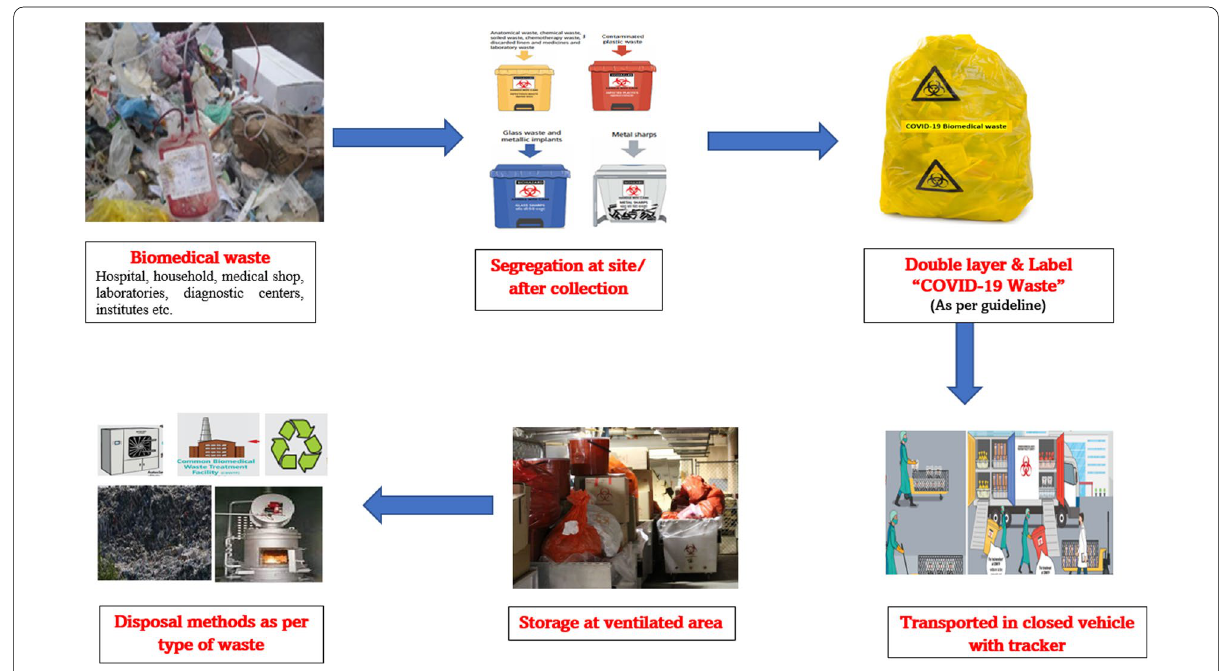
Fig. 4 Guidelines by the CPCB for COVID-19 medical waste